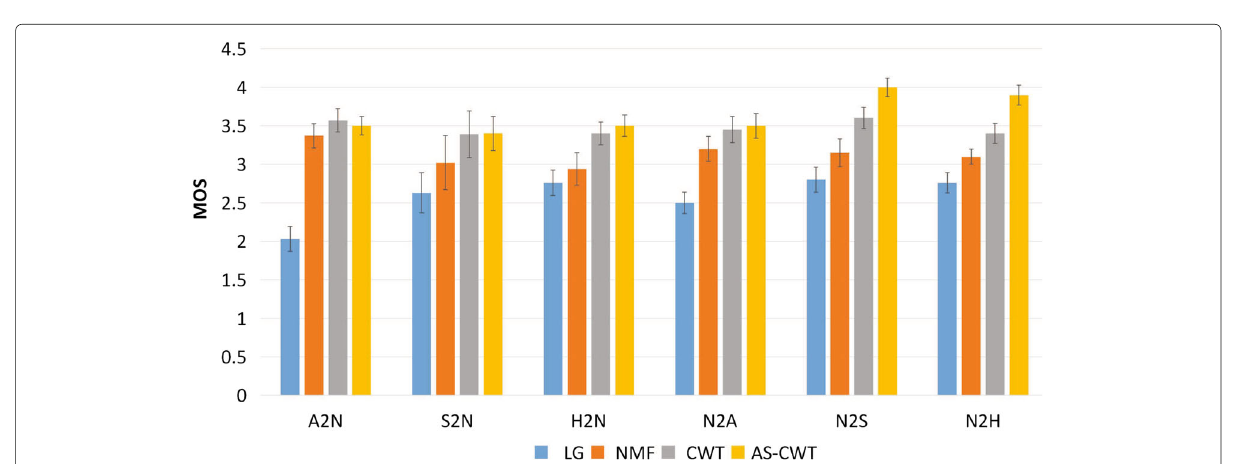
Fig. 14 MOS evaluation of emotional voice